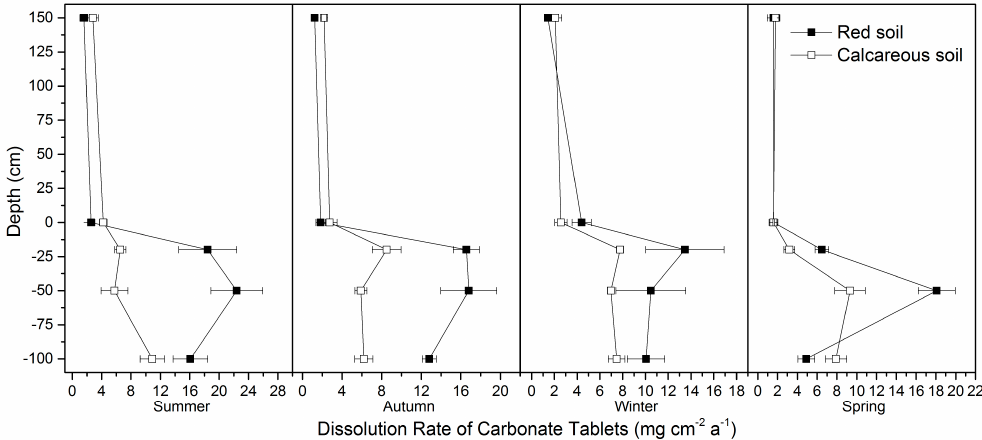
Figure 7. Dissolution rates in calcareous and red soils.